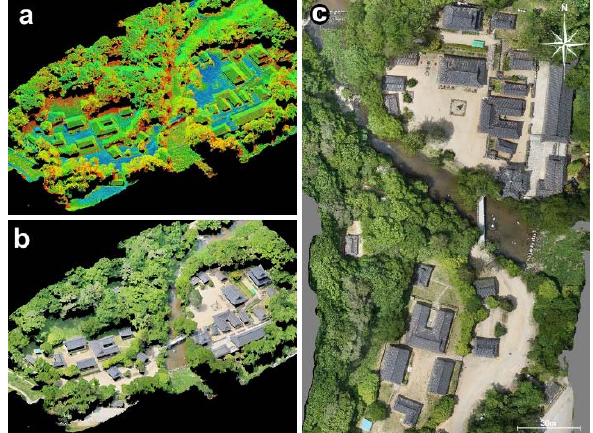
Figure 6. UAV photogrammetry results for the Magoksa Temple: (a) Point cloud data; (b) Texture mapping image; (c) Orthoimage